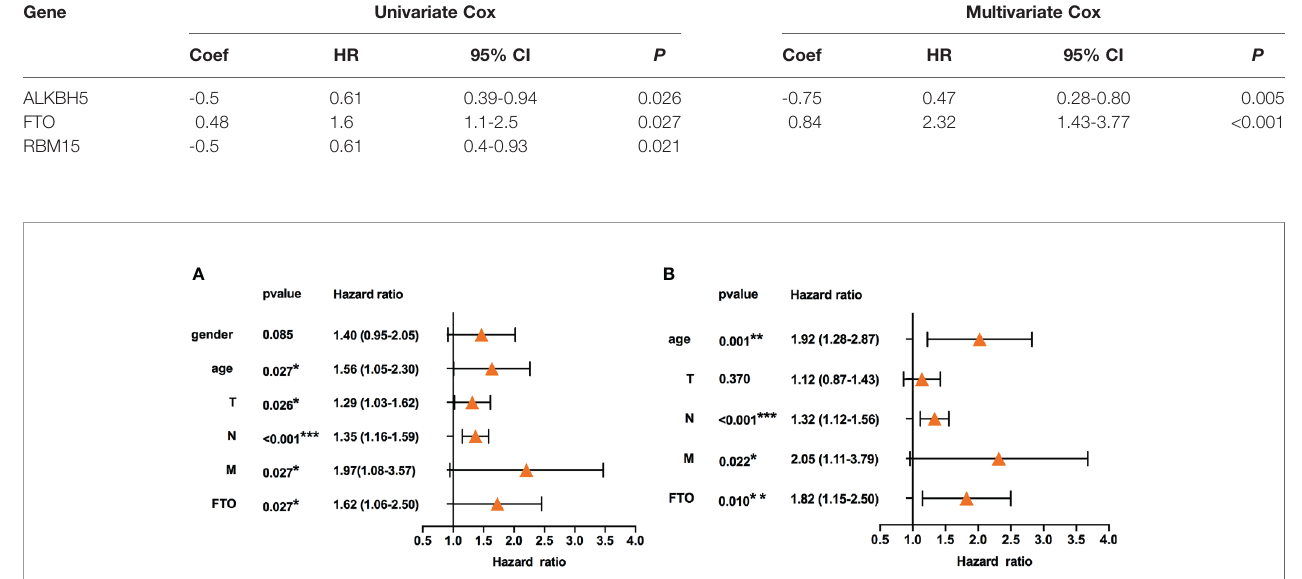
TABLE 2 | The univariate and multivariate Cox regression analysis of m6A RNA methylation regulators for OS in GC. Gene Univariate Cox Multivariate Cox HR 95% CI